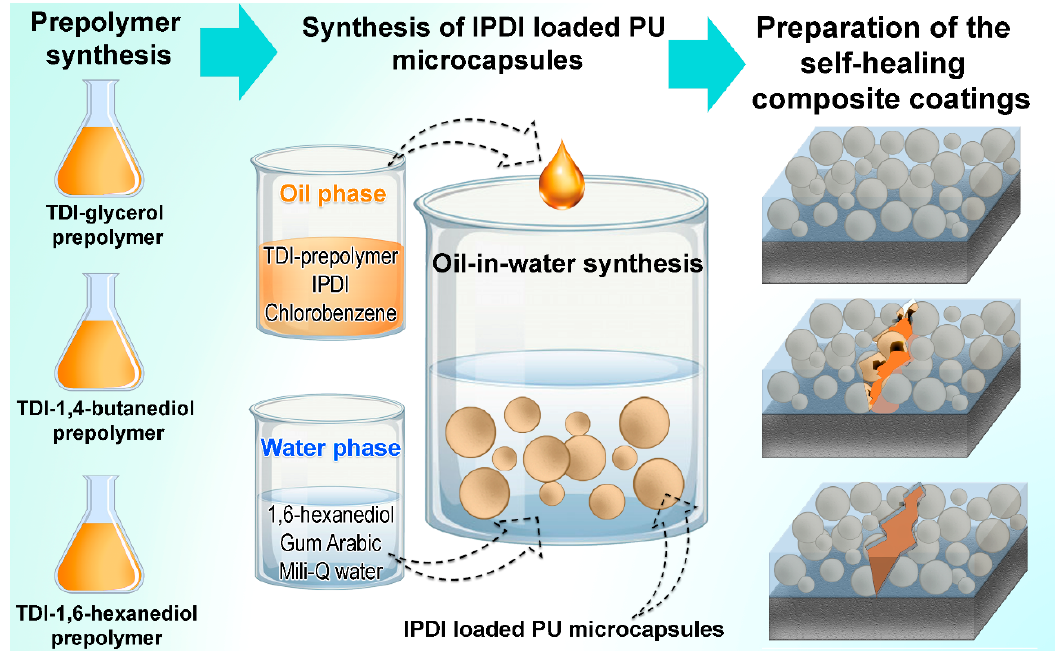
Figure 4. Schematic presentation of the sample preparation process.